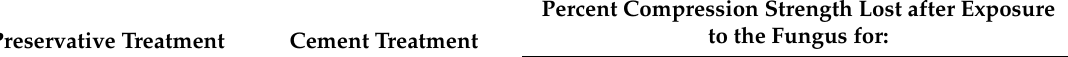
Table 2. Comparative decay resistance of untreated and preservative-treated pine wafers with and without cement infusion and exposed to Gloeophyllum trabeum in a soil block test. Each value is the average of eight replicates, with high values representing extensive decay.